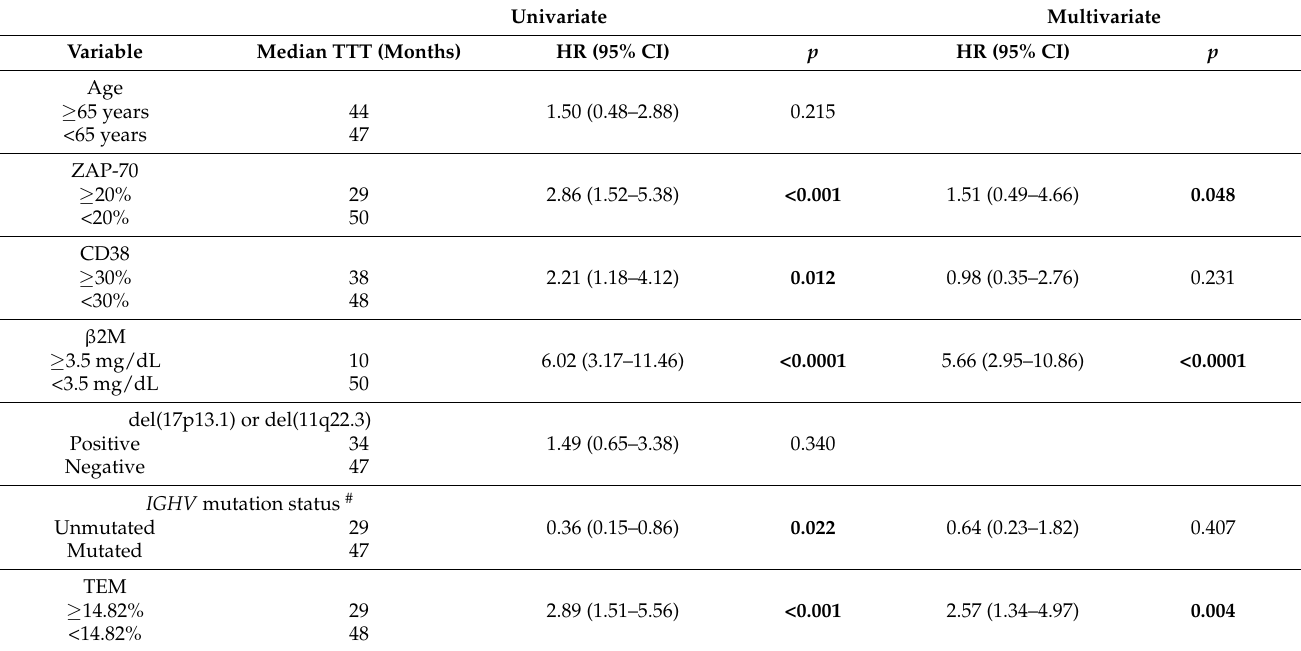
Table 3. Univariate and multivariate analysis for time to treatment.